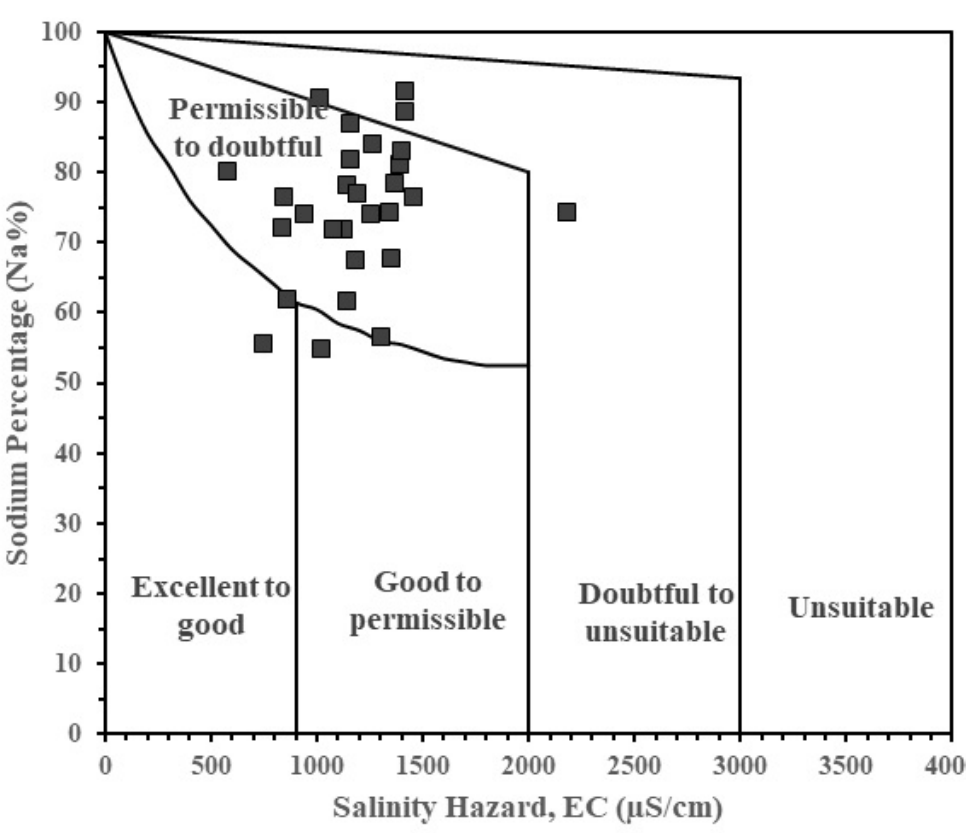
Figure 8. Wilcox plot for the study area.